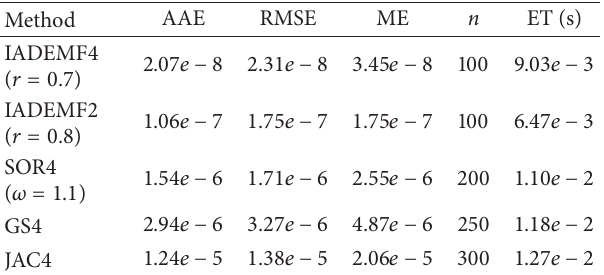
Table 8: Experiment 2. 𝑚 = 7000 , 𝜆 = 0.5 , Δ𝑥 = 1.43 × 10 −4 , Δ𝑡 = 1.02 × 10 −8 , 𝑡 = 5.10 × 10 −7 , and 𝜀 = 10 −10 .